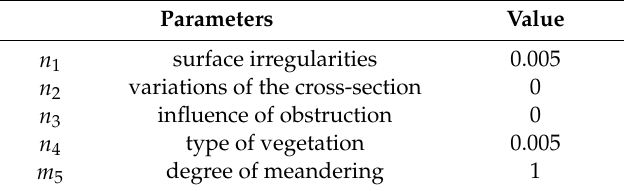
Table 2. Values assumed for the calculation of the roughness coe ffi cient of the river bed. Parameters Value n 1 surface irregularities 0.005 n 2 variations of the cross-section 0 n 3 influence of obstruction 0 n 4 type of vegetation 0.005 m 5 degree of meandering 1